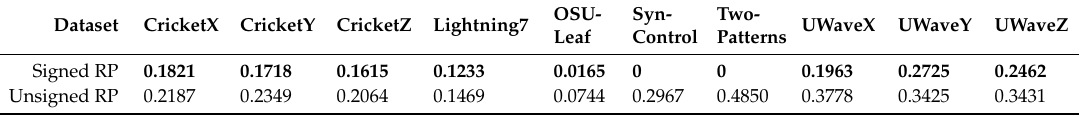
Table 5. Comparison in terms of error rates between signed RP and unsigned RP.